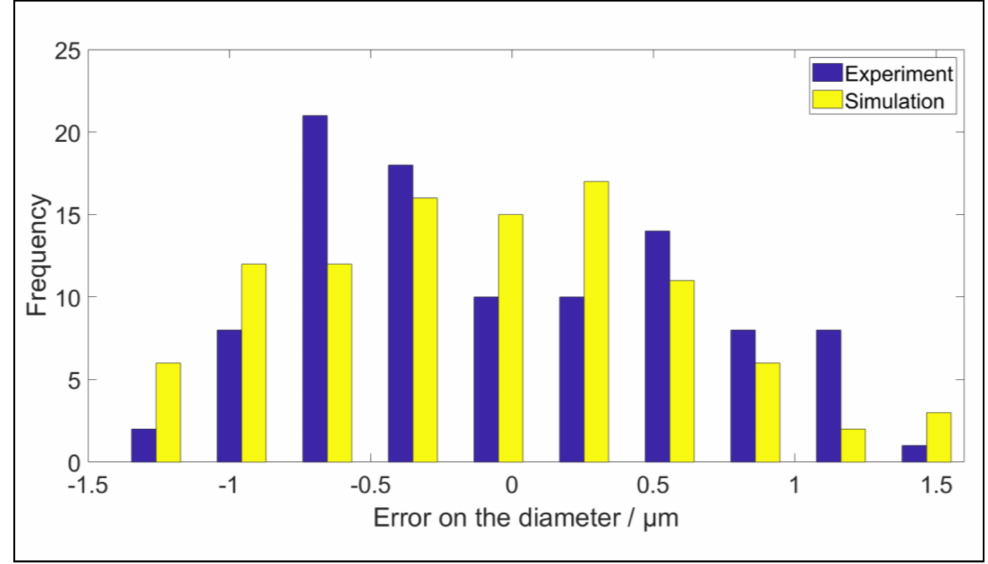
Figure 16. Comparison between the experimentally obtained diameters and the diameters obtained by